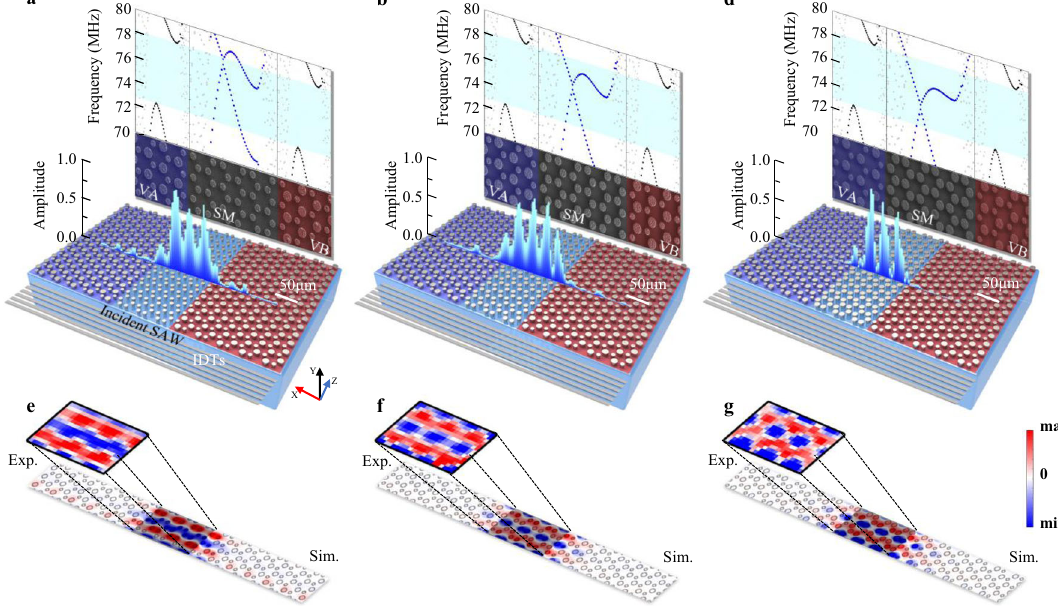
Fig. 5 ETVS ’ s stability to the doping of different energy barriers. a – c (bottom) Schematics of three heterostructured valley interfaces, when the radius of the micropillars of SMs increasing from a 4.3 μ m to b 5 μ m to c 5.8 μ m. (upper) SAW band structures of the corresponding SMs. Their SAW Dirac frequency decreases inside the VA/VB ’ s bulk bandgap. (middle) Experimentally measured SAW out-of-plane amplitude distributions crossing the doping areas. SAWs remain highly localized in all these cases. d – f Experiment and simulation SAW out-of-plane displacement distribution (at 76 MHz shown in the fi gures) depending on different doping.